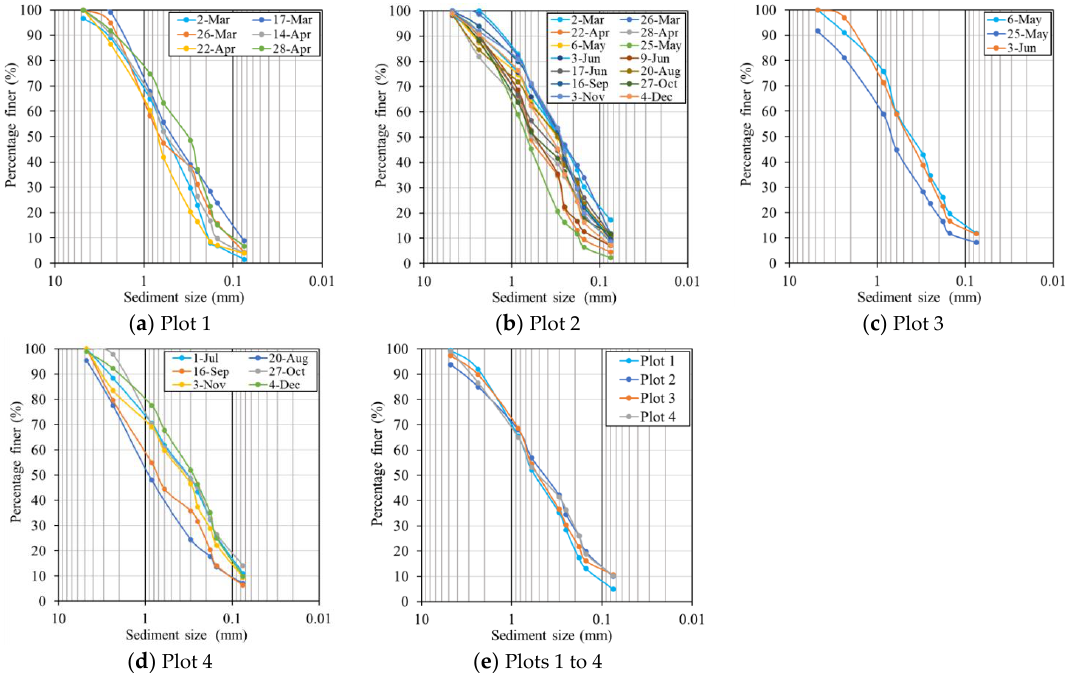
Figure 11. ( a ) to ( d ) Gradation curves of eroded soils from erosion Plots 1 to 4 during the monitoring period of March to December 2021, and ( e ) Representative gradation curve for Plots 1 to 4. The dates represent the site visits when the samples were collected from the plots.